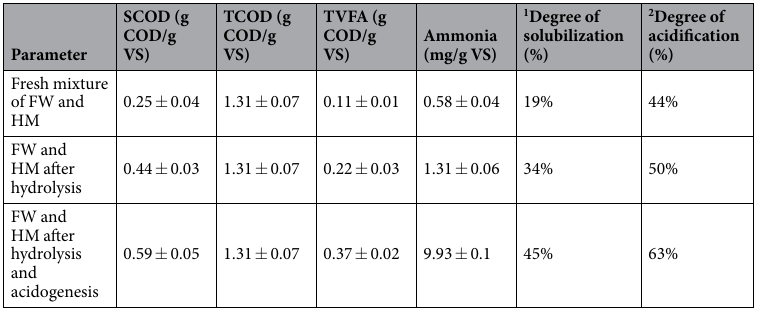
Table 1. Characteristics of feedstocks after hydrolysis and acidogenesis. Data are the averages of the values obtained. Error bars represent standard deviations of statistical analysis. Degree of solubilization is expressed as the quotient between Soluble COD (SCOD) and Total COD (TCOD) 22 . Degree of acidification is defined as the ratio of COD-equivalent TVFA to SCOD 23